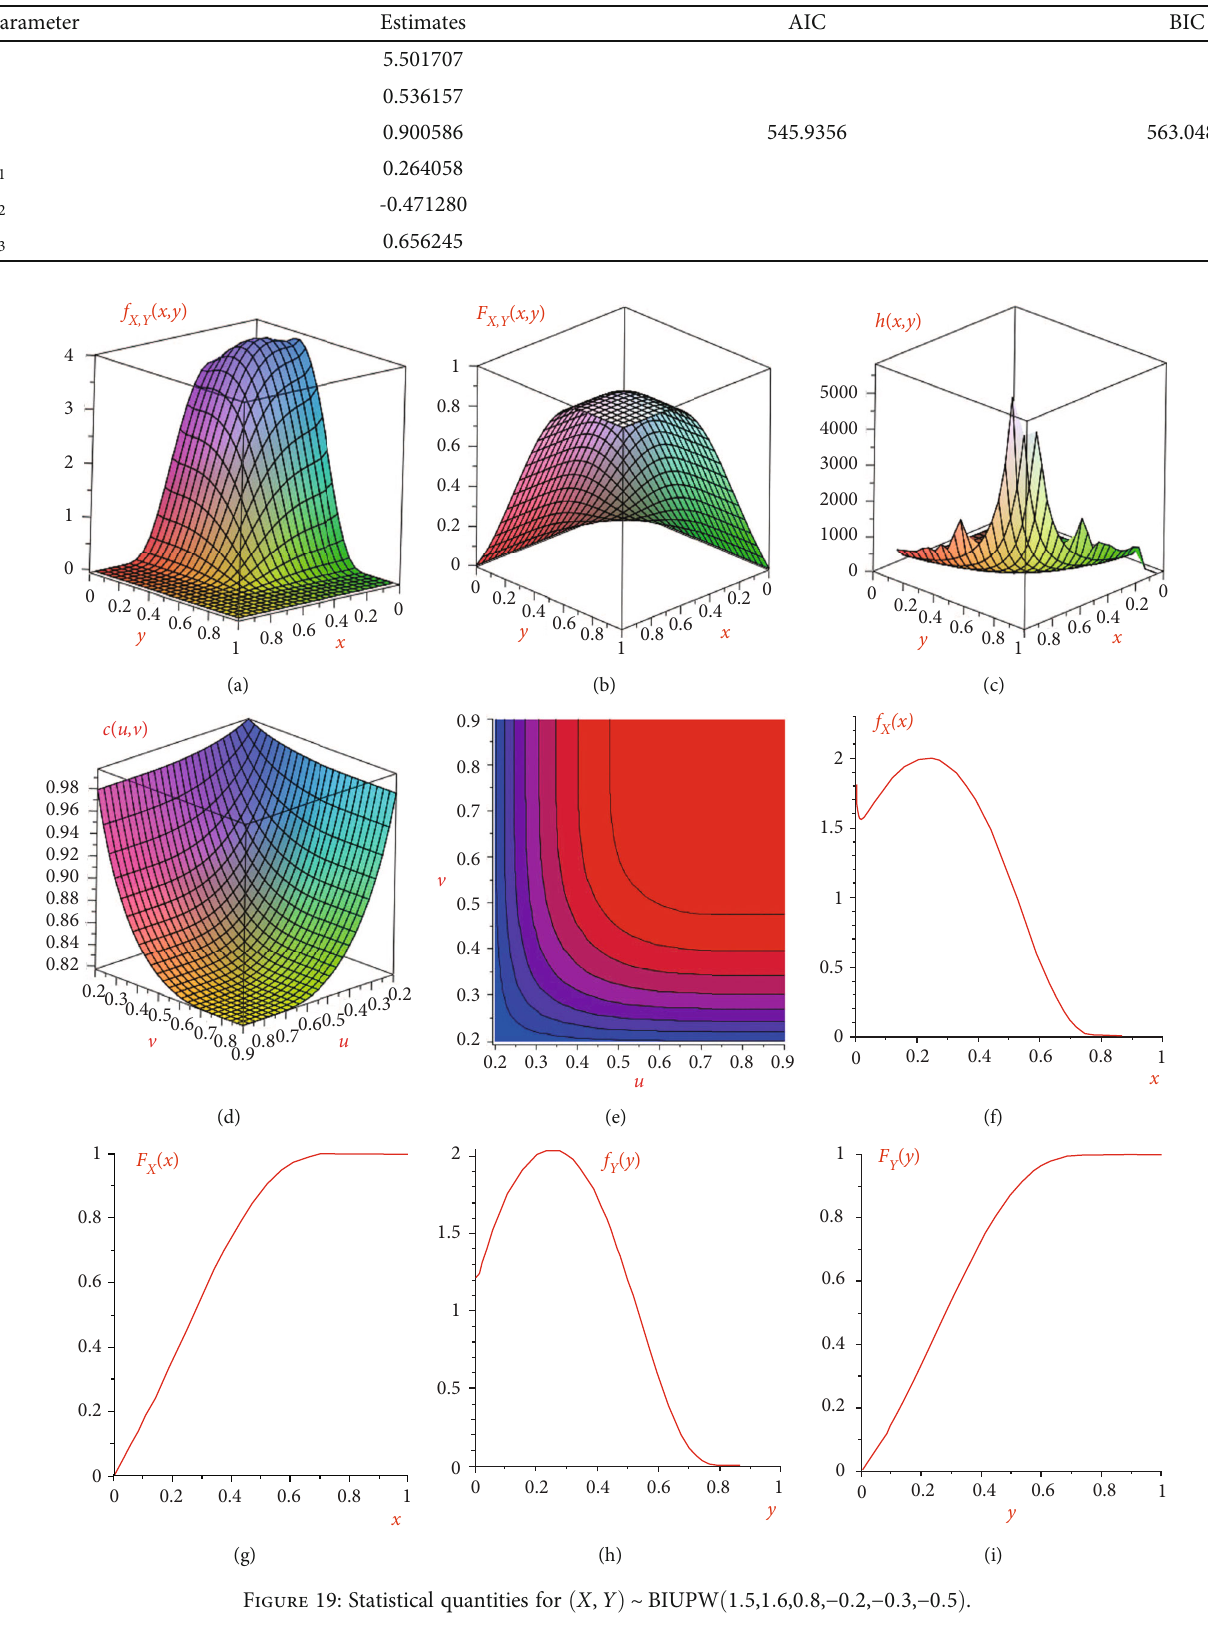
Þ with AIC and BIC. , θ , θ 1 2 3